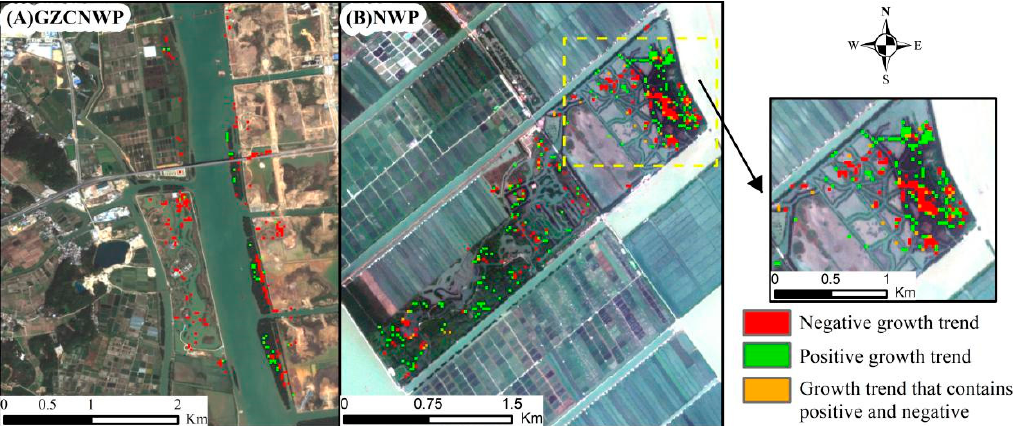
Figure A7. The growth trends of stable mangroves occurred in ( A ) GZCNWP and ( B ) NWP in 2000–